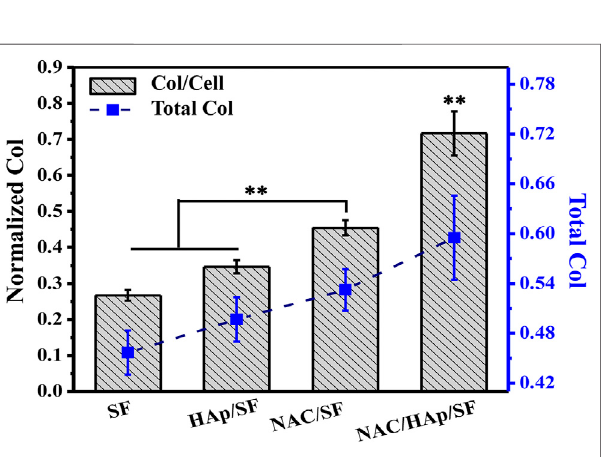
Frontiers in Bioengineering and Biotechnology |